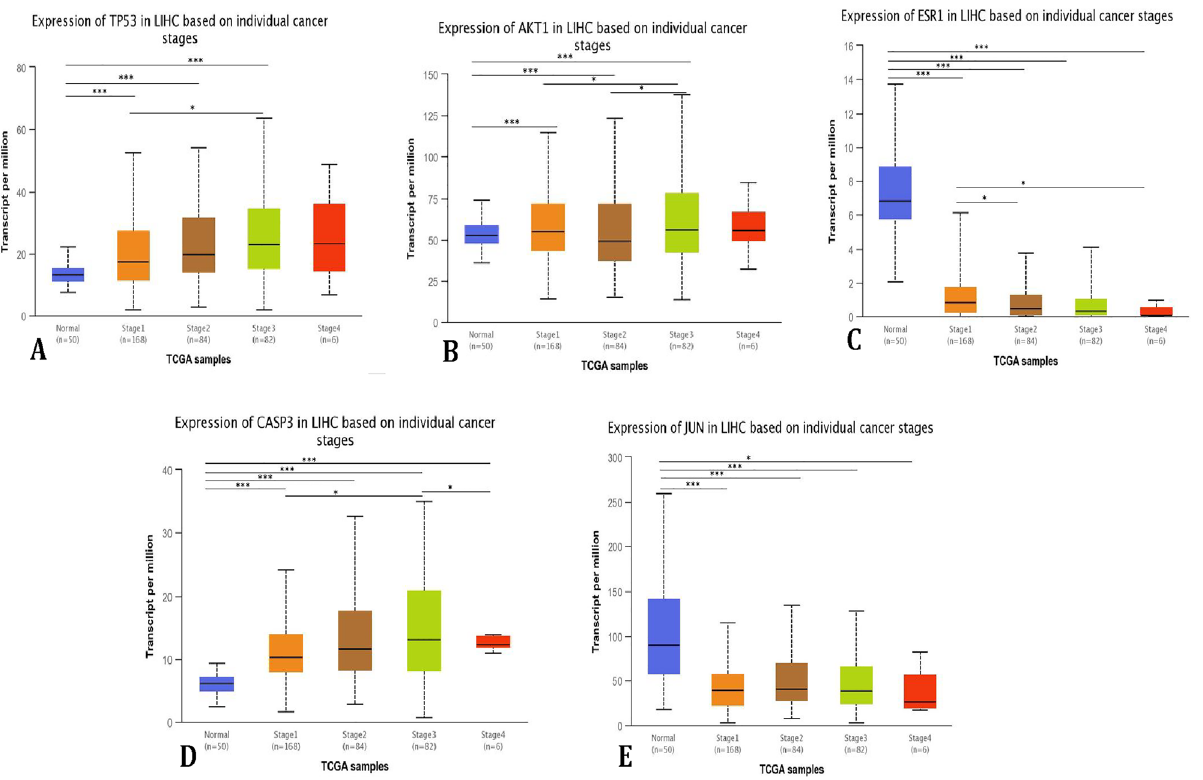
Figure 6. The mRNA expression of the TP53 ( A ), AKT1 ( B ), ESR1 ( C ), JUN ( D ) and CASP3 ( E ) in individual cancer(*p < 0.05, ***p < 0.001) (http:// ualcan. path. uab.